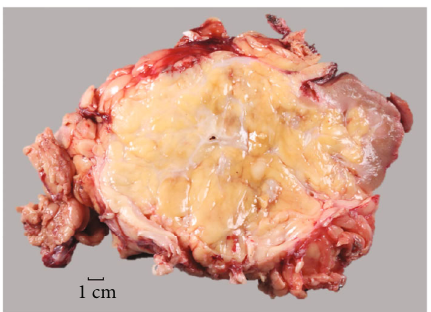
Figure 2: Gross photograph of bisected right kidney. The kidney is largely replaced by an extensive fatty proliferation of the renal sinus fat. There is adjacent surrounding residual compressed red-brown renal